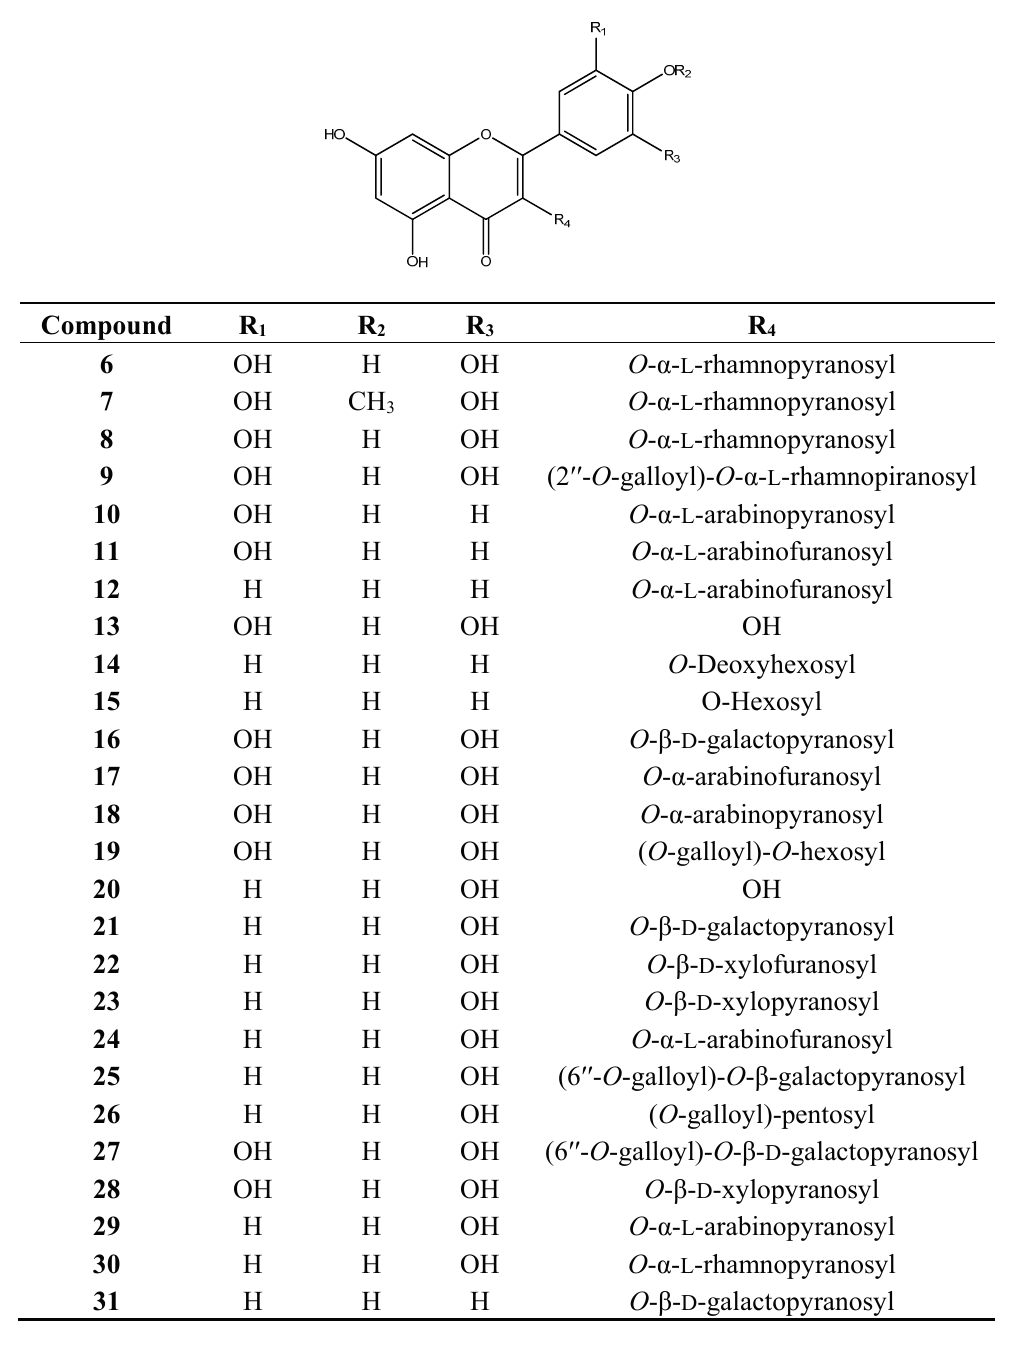
Figure 2. Structures of the flavonols and their glucosides isolated from Myrcia . Studies with the leaves of M. hiemalis Cambess. led to the isolation of 5-hydroxy-6,8- dimethyl-7-methoxyflavanone ( 32 ), 6,8-dimethyl-5,7-dimethoxyflavanone ( 33 ) and 2,7-dihydroxy-6,8- dimethyl-5-methoxyflavanone ( 34 ), together with the chalcones 2 ʹ ,4 ʹ -dihydroxy-3 ʹ ,5 ʹ -dimethyl-4,6 ʹ - dimethoxychalcone ( 35 ), 2 ʹ -hydroxy-3 ʹ ,5 ʹ -dimethyl-4 ʹ ,6 ʹ -dimethoxychalcone ( 36 ) and 2 ʹ ,6 ʹ -dihydroxy- 3 ʹ ,5 ʹ -dimethyl-4 ʹ -methoxychalcone ( 37 ) and the isoflavone 7-hydroxy-6,8-dimethyl-5-methoxy- isoflavone ( 38 ) [55]. Myrcia hiemalis was the only species from which chalcones, C-methylflavanones and isoflavones were